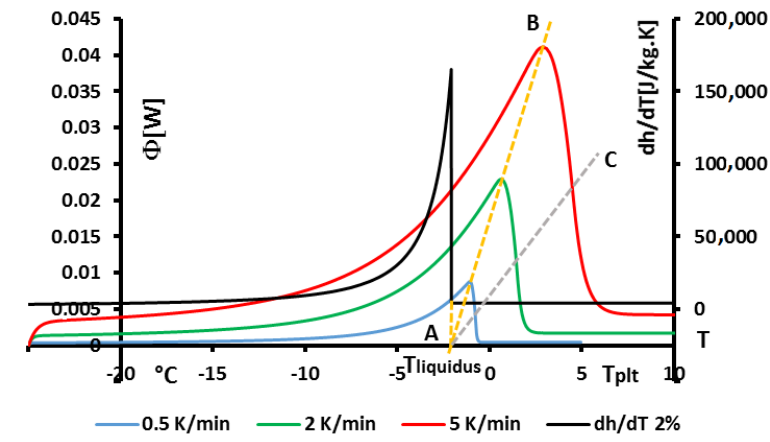
Figure 21. Thermogram of a melting at different rates β of an aqueous solution for y 0 = 2% and the d h corresponding d T